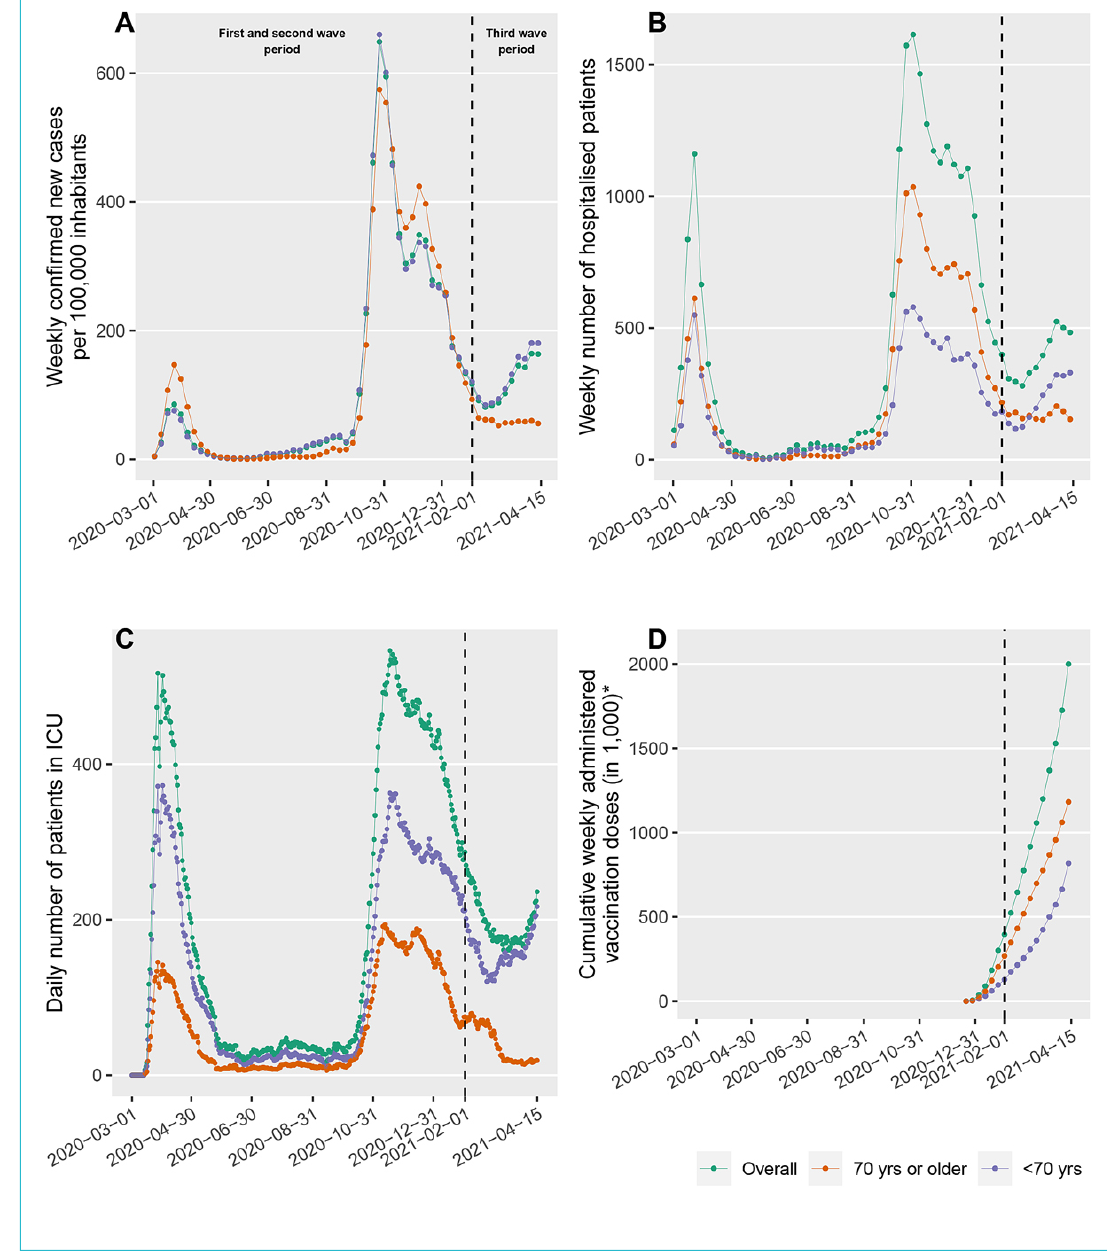
Figure 1: The number of positive test results for SARS-CoV-2 per 100,000 inhabitants (A) indicates three pandemic wave periods, which are reflected in the number of hospitalised patients (B) and absolute number of patients treated in the intensive care unit (ICU) (C). The propor- tions of patients older and younger than 70 years remained stable throughout the first and second wave periods and from the onset of the third wave period shifted towards the younger patients. This effect was most pronounced in the patients treated in the ICU. The total number of vac- cine doses applied is given in (D). The data in (A, B, D) were provided by the Federal Office of Public Health (FOPH). The overall absolute number of patients treated in the ICU as reported by www.icumonitoring.ch / Koordinierter Sanitätsdienst (KSD; C, green line) was stratified by age using per-day age distributions derived from the RISC-19-ICU registry (C, blue and orange